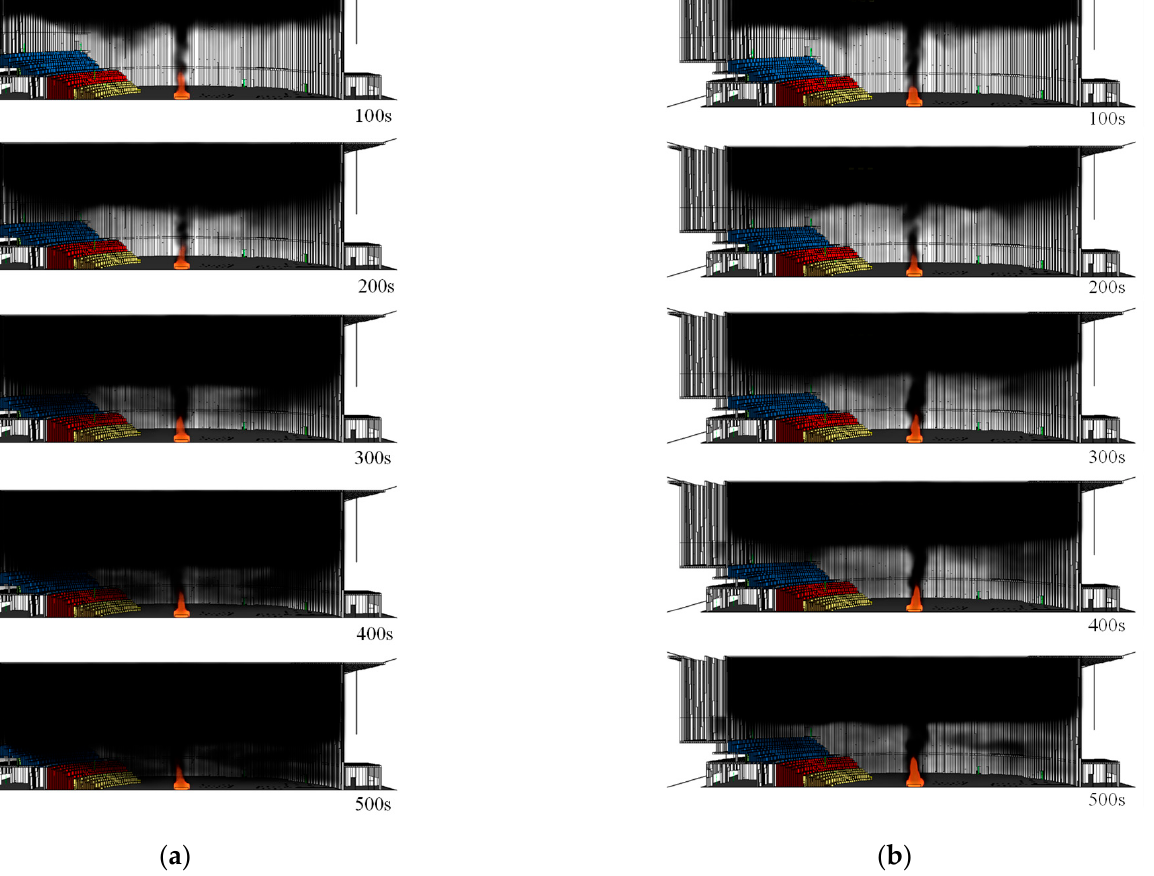
Figure 14. Smoke filling process in the theater. ( a ) Smoke extraction system off; ( b ) smoke extraction system on.